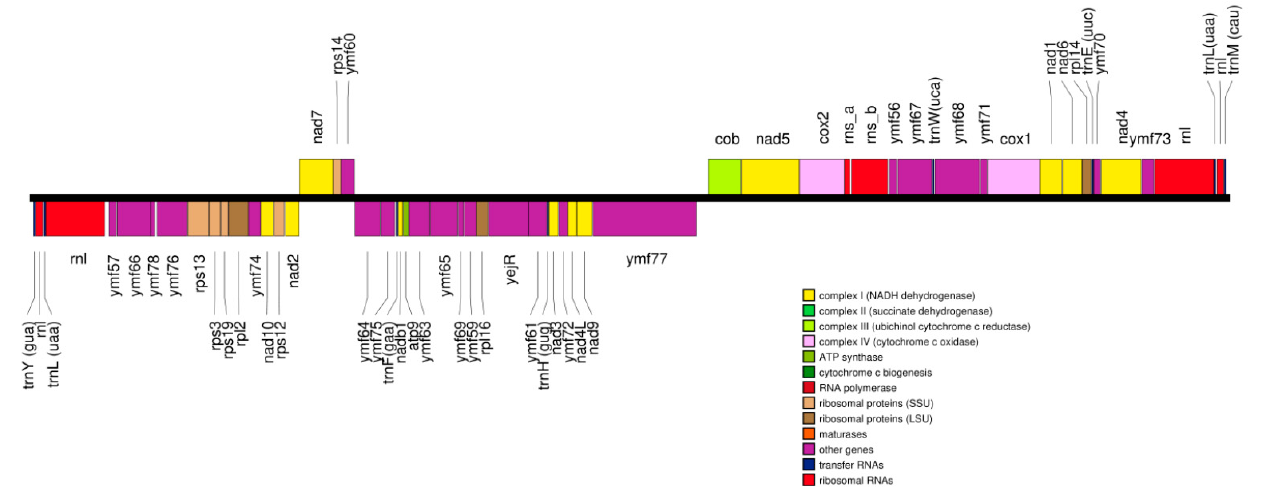
Figure 2. Arrangement of ORFS in the T. rostrata mitogenome.